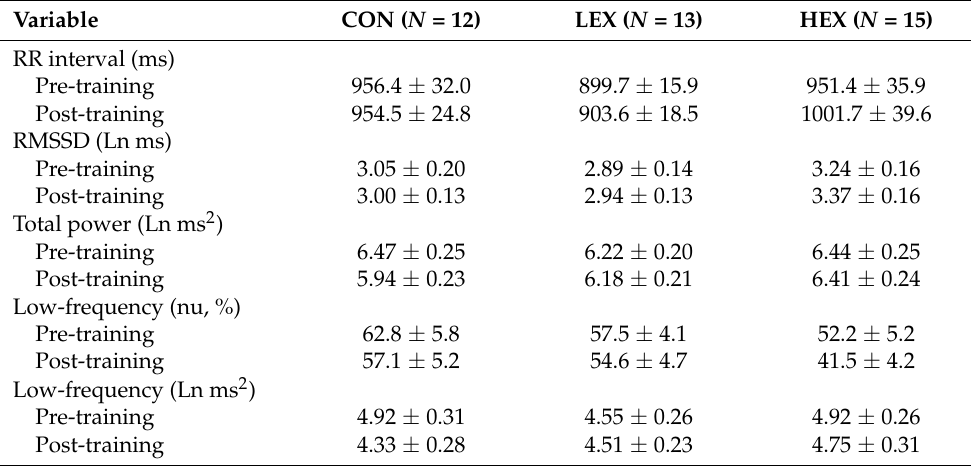
Table 3. Changes in resting HRV measures for the CON, LEX, and HEX groups following 24 weeks of resistance training or a control